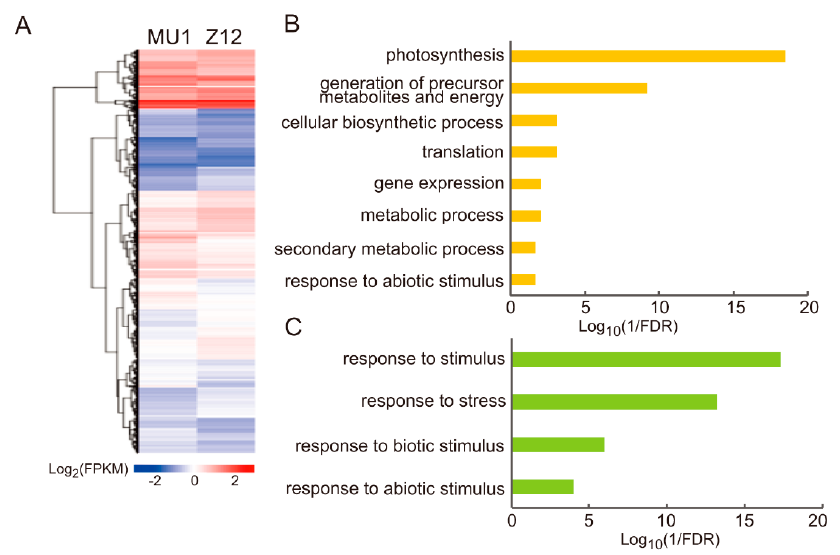
Figure 6. Genome-wide transcriptomic differences between MU1 and Z12. ( A ) Heatmap of genes differentially expressed between MU1 and Z12. Biological function of up-regulated genes. ( B ) And down-regulated genes ( C ) in MU1, based on GO analysis.